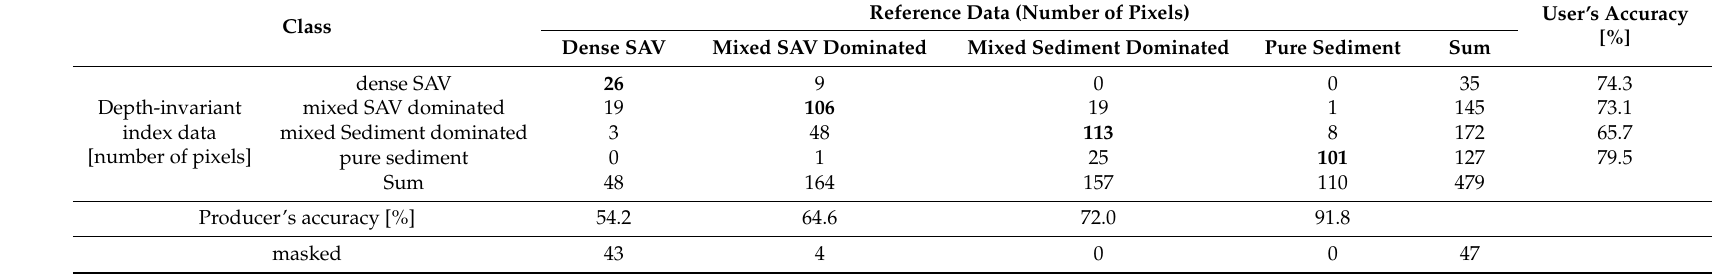
Table 3. Error matrix and class accuracy measures of categorized Y 3,4 (1 August) based on Google Earth imagery (9 August) reference data. The number of reference pixels is about 2.5% of the investigated